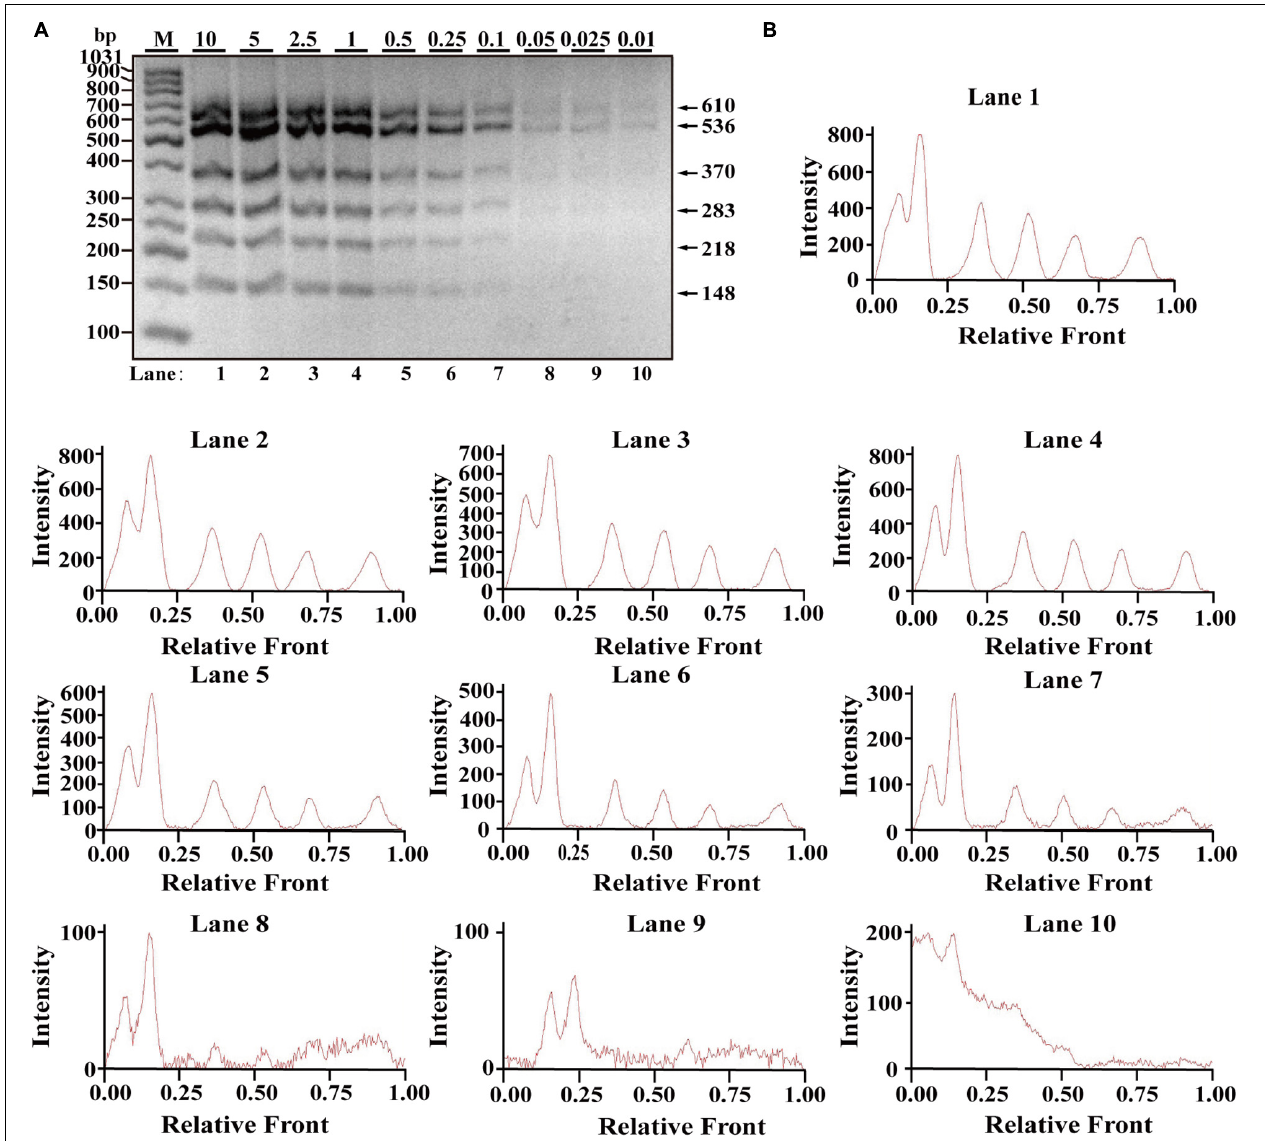
FIGURE 1 | Validation of the sensitivity of the one-tube hexaplex PCR assay. (A) Gel image of multiplex PCR fragments amplified with six primer pairs and DNA mixture of six species: horse, pigeon, camel, rabbit, ostrich, and beef under the indicated concentration in a single PCR reaction. (B) Using Image Lab Software, electropherograms were drawn based on bands. Lanes 1–10 are represented labels of 10, 5, 2.5, 1, 0.5, 0.25, 0.1, 0.05, 0.025, and 0.01 in (A) . The value of number in the horizontal line means the relative position of peaks distant from the top of agarose gel. The value of number at the vertical line means the fluorescent intensity of PCR fragments using 4S GelRed Nucleic Acid Stain. Lane M is ladder